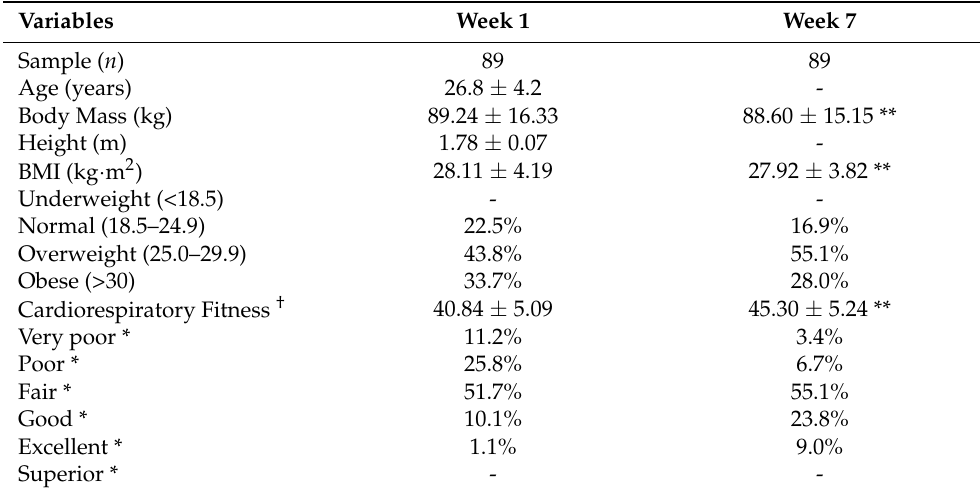
Table 1. Participant Descriptive Statistics at Weeks 1 and 7.